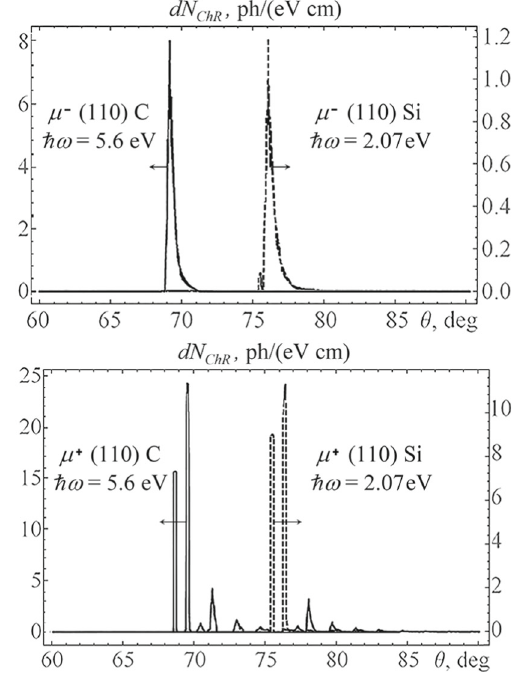
Fig. 7 ChCRangulardistributionsforthefrequenciesofopticalcrystal transparency 2 . 07 eV for Si and 5 . 6 eV for C